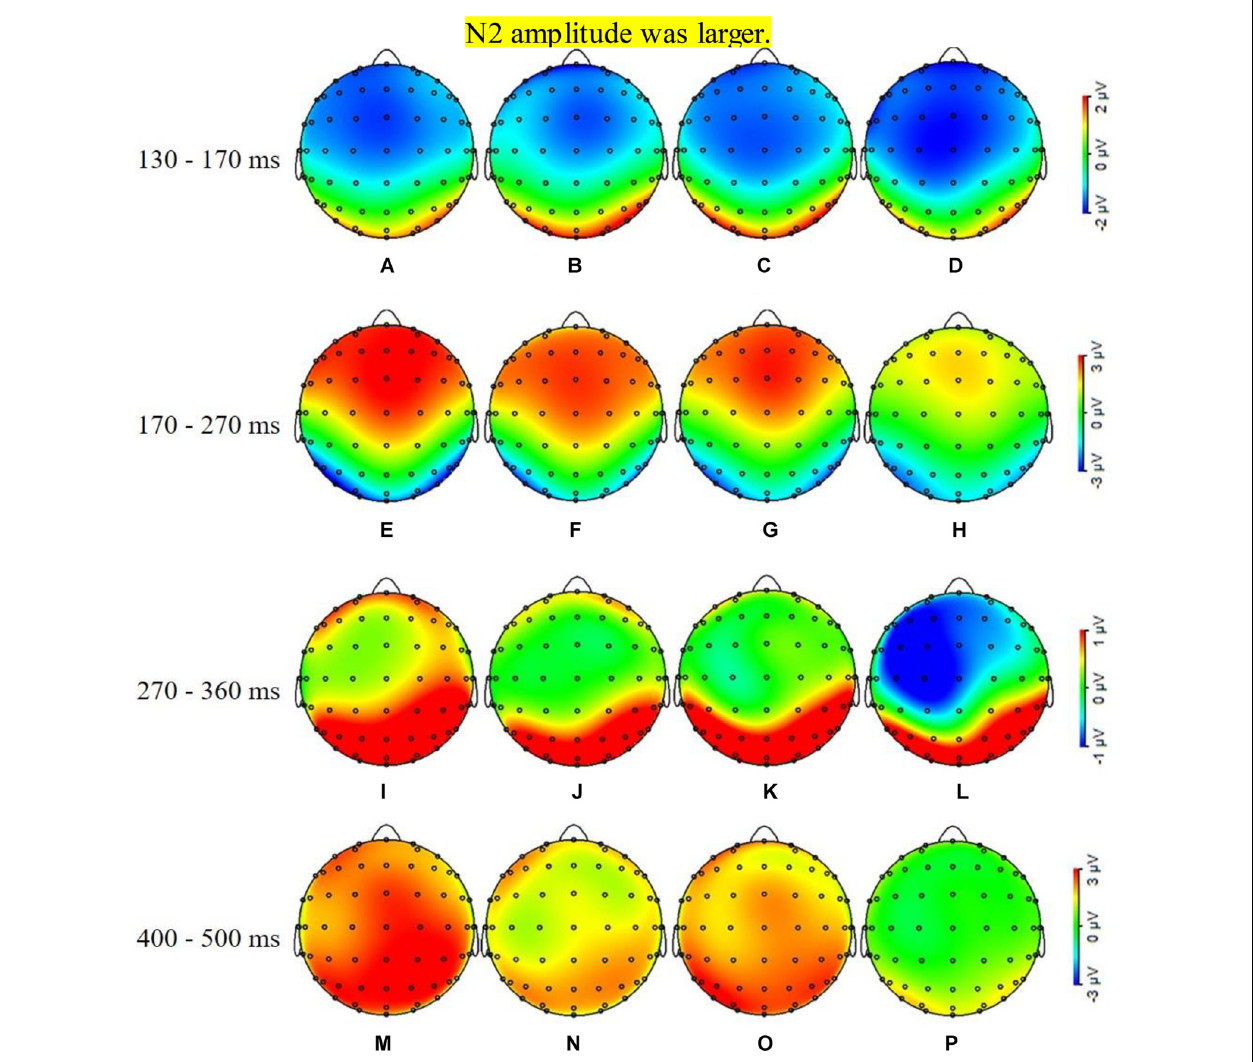
FIGURE 5 | ERPs mapping of correct and error trials at the time interval of peak amplitudes. Panels (A,B) show the N1 mapping of correct and error ERP in normal, panels (C,D) show the N1 mapping of correct and error in fatigue, respectively; there is no difference at the prefrontal and central areas in the four figures. Panels (E,F) show the P2 mapping of correct and error ERP in normal, panels (G,H) show the P2 mapping of correct and error in fatigue, respectively; the amplitudes in fatigue state and the amplitudes of error were smaller in the Fz and Cz. Panels (I,J) show the N2 mapping of correct and error ERP in the normal state, panels (K,L) show the N2 mapping of correct and error in fatigue, respectively; the amplitudes of error were larger in the Fz, Cz, and Pz. Panels (M,N) show the P3 mapping of correct and error ERP in the normal state, panels (O,P) show the P3 mapping of correct and error in fatigue, respectively; the amplitudes of fatigue and the amplitudes of error were smaller in the Fz, Cz, and